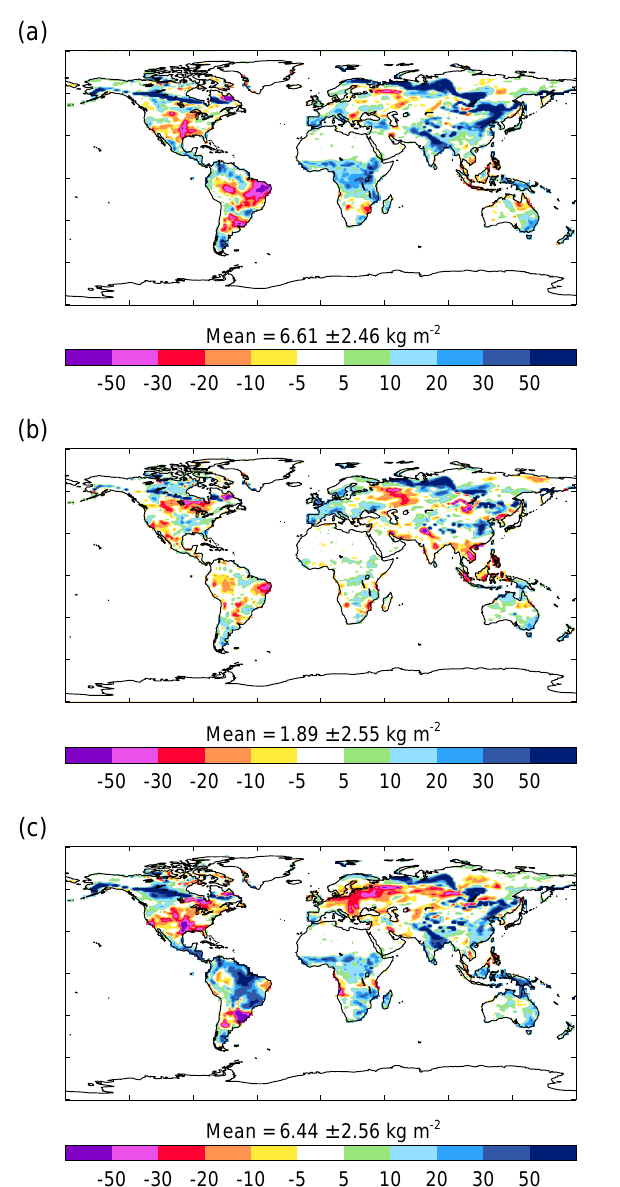
Fig. 7. (a) Mean 2040-2069 change in soil moisture content (kg m − 2 ) with respect to RCP4.5 when using the I-mask distribution for emitting geoengineered sea-spray. (b) As (a) but using the D- mask emission pattern. (c) As (a) but using I-mask NSA .